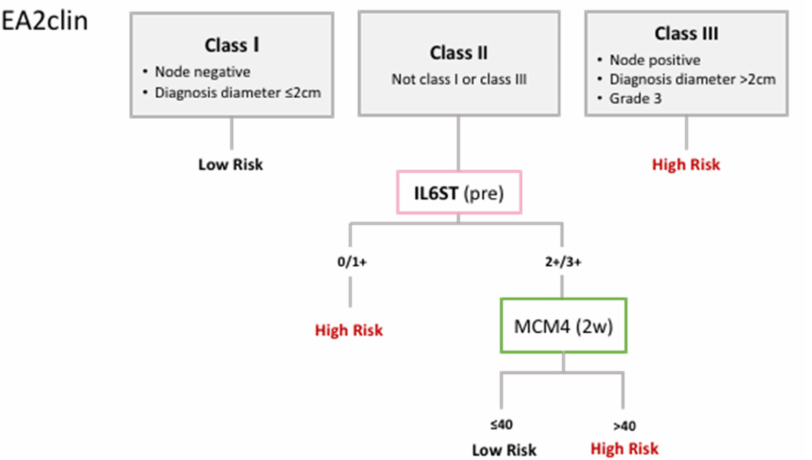
Figure 3. Summary of the markers included in the different predictive models developed in Edin- burgh: the 4-gene classifier Edinburgh EndoResponse 4 (EER4) incorporates the expression level of 2 genes at pretreament (pre) and 2 genes after 2 weeks of neoadjuvant endocrine therapy (2w); this was simplified into the EndoAdjuvant2 (EA2) signature, which uses IHC assessment of the 2 main classifiers to stratify cases into discrete risk groups; EndoAdjuvant2 clinical (EA2clin) combined EA2 with clinical factors to produce a more accurate hybrid